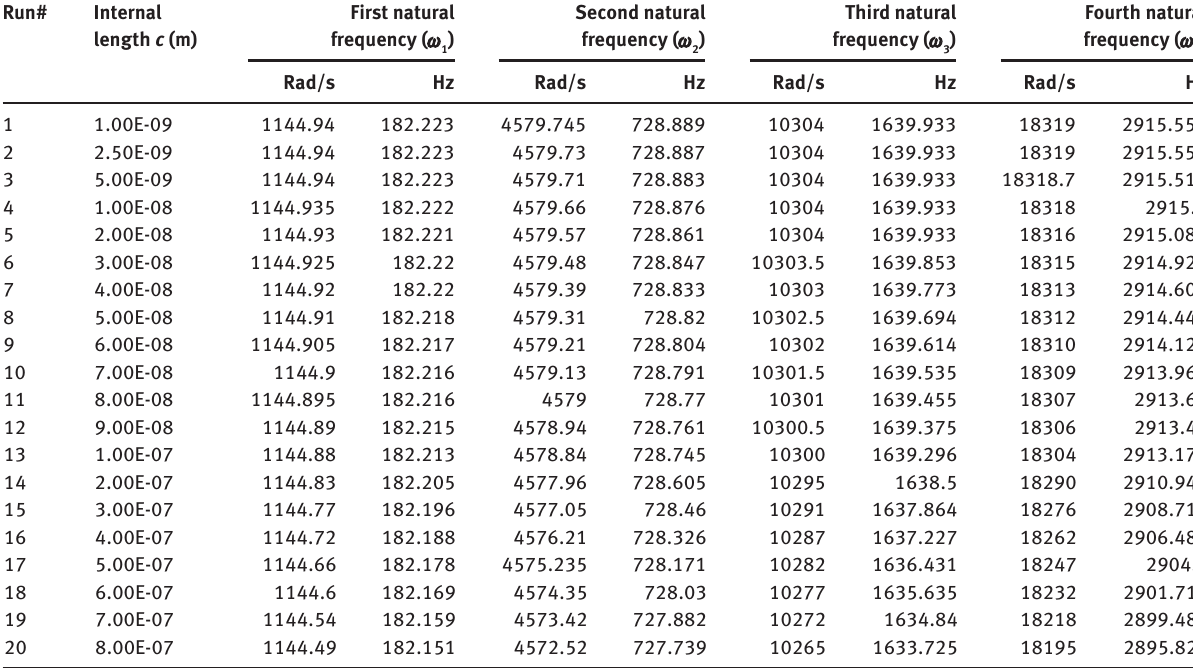
Table 4: Frequencies for simply supported beam in gradient material